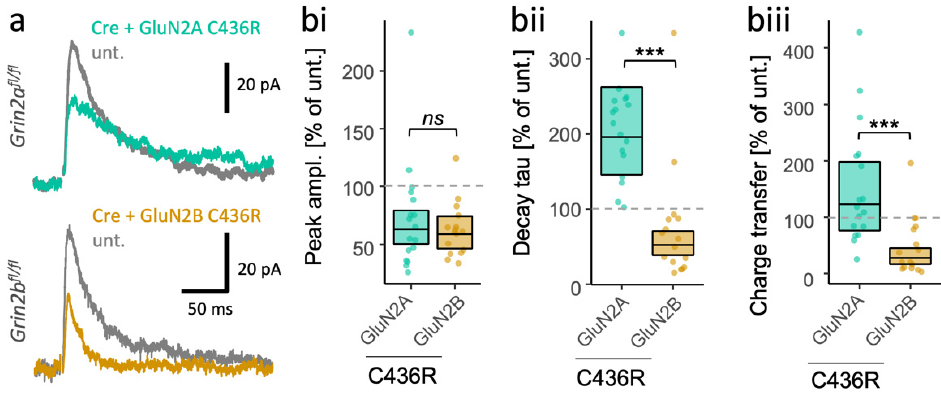
Figure 5. Subunit-dependent outcome of identical disease-associated LoF mutations in GRIN2A and GRIN2B . ( a ) Representative NMDA-EPSCs (average of 10 sweeps) from Grin2b fl/fl (untransfected abbrv. unt.) neurons, and Grin2b − / − neurons rescued with human GluN2A C436R or GluN2B C436R . ( b ) Ratios (transfected/untransfected) of the response (peak amplitude, decay time constant or charge transfer) are expressed as a percentage and plotted for each pair of transfected-untransfected neurons. Crossbars in (ii) and (iii) show the estimated marginal means with 95% confidence intervals backtransformed from the linear mixed models (LMM). The p-values from the hypothesis tests are derived from the same LMM (Figures S1.9–S1.11). Standardised effect sizes ( r ) for GluN2 subunit background (of the C436R mutation) on response ratios were (bi) for peak amplitudes, − 0.08; ( bii ) for decay taus, − 0.75; and ( biii ) for charge transfer, − 0.62 (N = 33). ns = not significant (at α = 0.05), *** = p < 0.001.